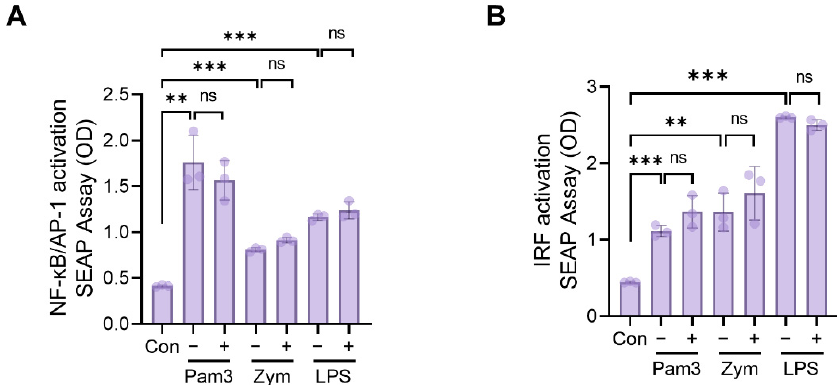
Figure 7. N,N (cid:48) -dicoumaroylspermidine has no effect on activation of NF-kB, AP-1, and IRF. ( A ) NF-kB, AP-1, and ( B ) IRF reporter cells (THP1-Xblue and THP1-Blue-ISG cells, respectively) were preincubated with (+) or without ( − ) 50 µ M of N,N (cid:48) -dicoumaroylspermidine for 1 h, followed by stimulation for 24 h with the TLR2/1 agonist Pam3 (100 ng/mL), the TLR2/6 agonist Zym (10 µ g/mL), and the TLR4 agonist LPS (100 ng/mL). Data are expressed as the mean ± SD. ** p < 0.01 and *** p < 0.001 versus the control group. ns = not significant ( t -test). Experiments were independently repeated three times. Con, control; Pam3, Pam3CSK4; Zym, zymosan A; LPS,